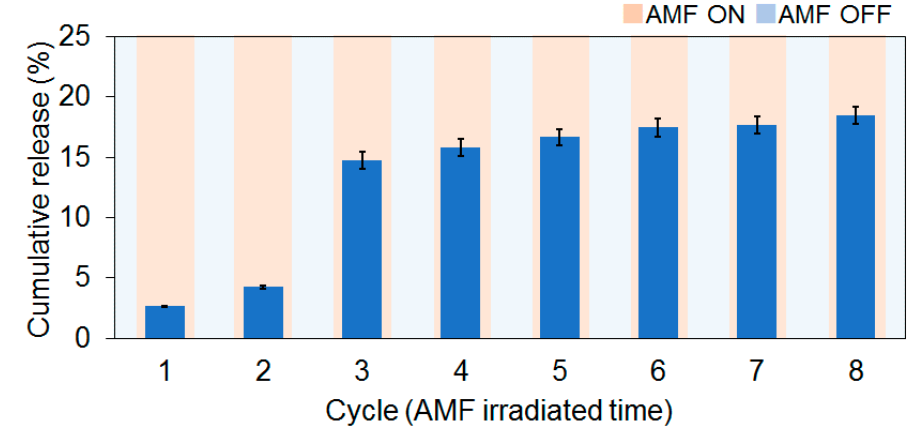
Figure 6. PTX release from the fiber in response to AMF irradiation.